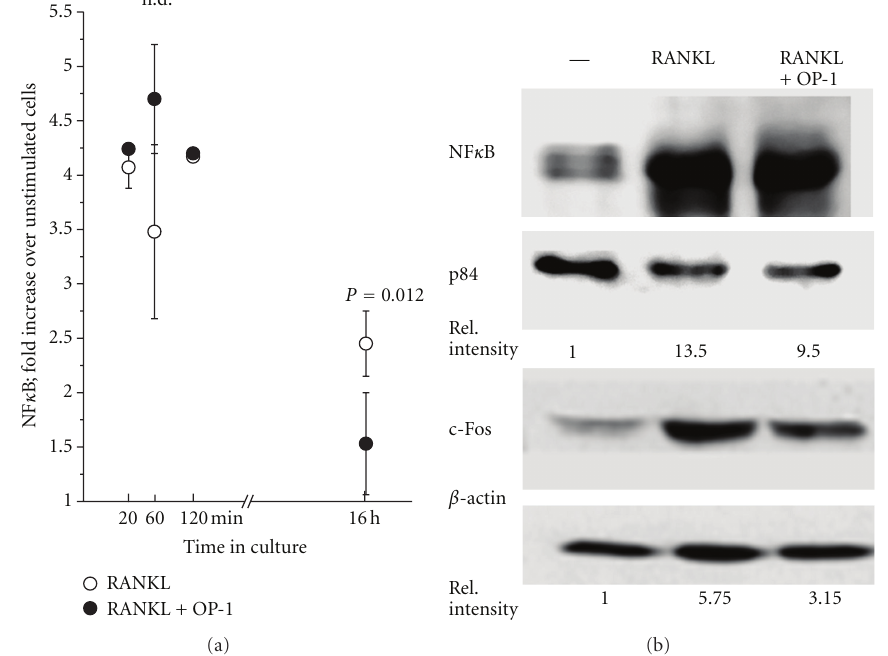
Figure 3: Translocation of NF κ B into the nucleus and induction of c-Fos: (a) NF κ B was determined by ELISA in the nucleus of monocytes treated with RANKL ( ◦ ) or RANKL + OP-1 ( • ) for the times indicated. The data points are compiled from experiments with cells of four individual donors (with exception of time point 120 min; here data of only one donor were available). By 16h, the mean values obtained for RANKL and the RANKL + OP-1 treated cells were di ff erent as calculated by t -test. (b) By Western blotting, NF κ B was assessed in the nucleus in unstimulated cells, cells stimulated with RANKL or with RANKL + OP-1 (24h). The relative intensity of the bands was determined using p84 as a nuclear housekeeping protein. c-Fos was determined in the cell lysates of monocytes stimulated as described above. Here actin was used as loading